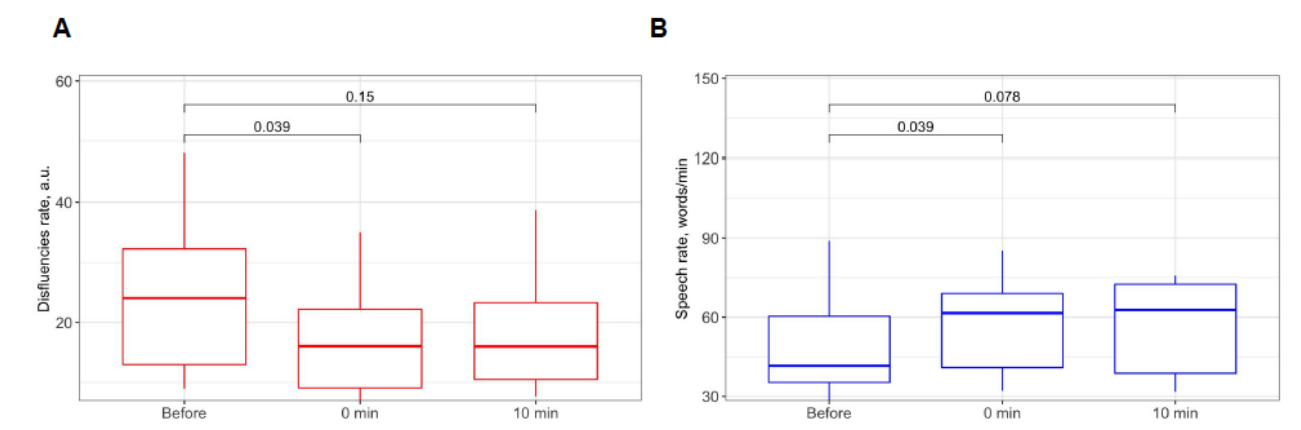
Figure 5. Speech disfluency and speech rate during experiments. ( A ) Speech disfluency rate before, after, and 10 min after binaural beats stimulation. ( B ) Speech rate before, after, and 10 min after binaural beats stimulation.